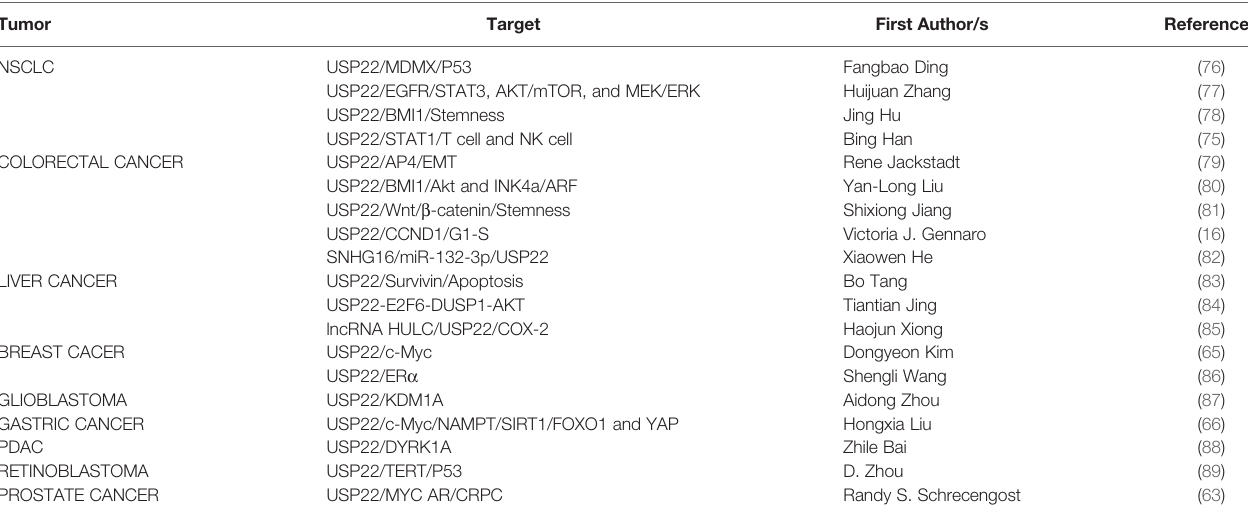
TABLE 1 | USP22 as a target for